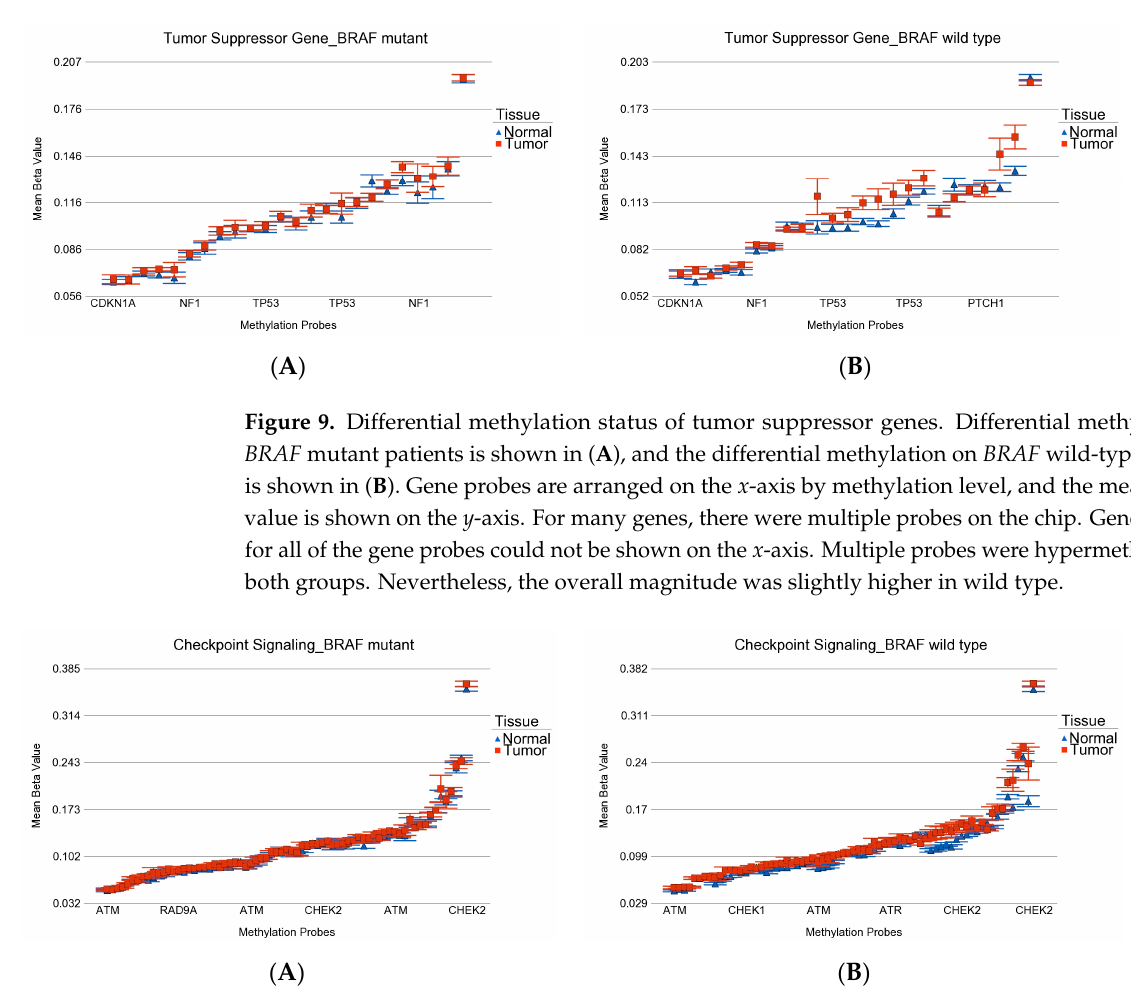
Figure 10. Differential methylation status of checkpoint signaling genes. Differential methylation in BRAF mutant patients is shown in ( A ), and the differential methylation of BRAF wild-type patients is shown in ( B ). Gene probes are arranged on the x -axis by methylation level, and the mean of beta value is shown on the y -axis. For many genes, there were multiple probes on the chip. Gene symbols for all gene probes could not be shown on the x -axis. Multiple probes were hypermethylated in both groups. However, the overall magnitude was slightly higher in wild type.